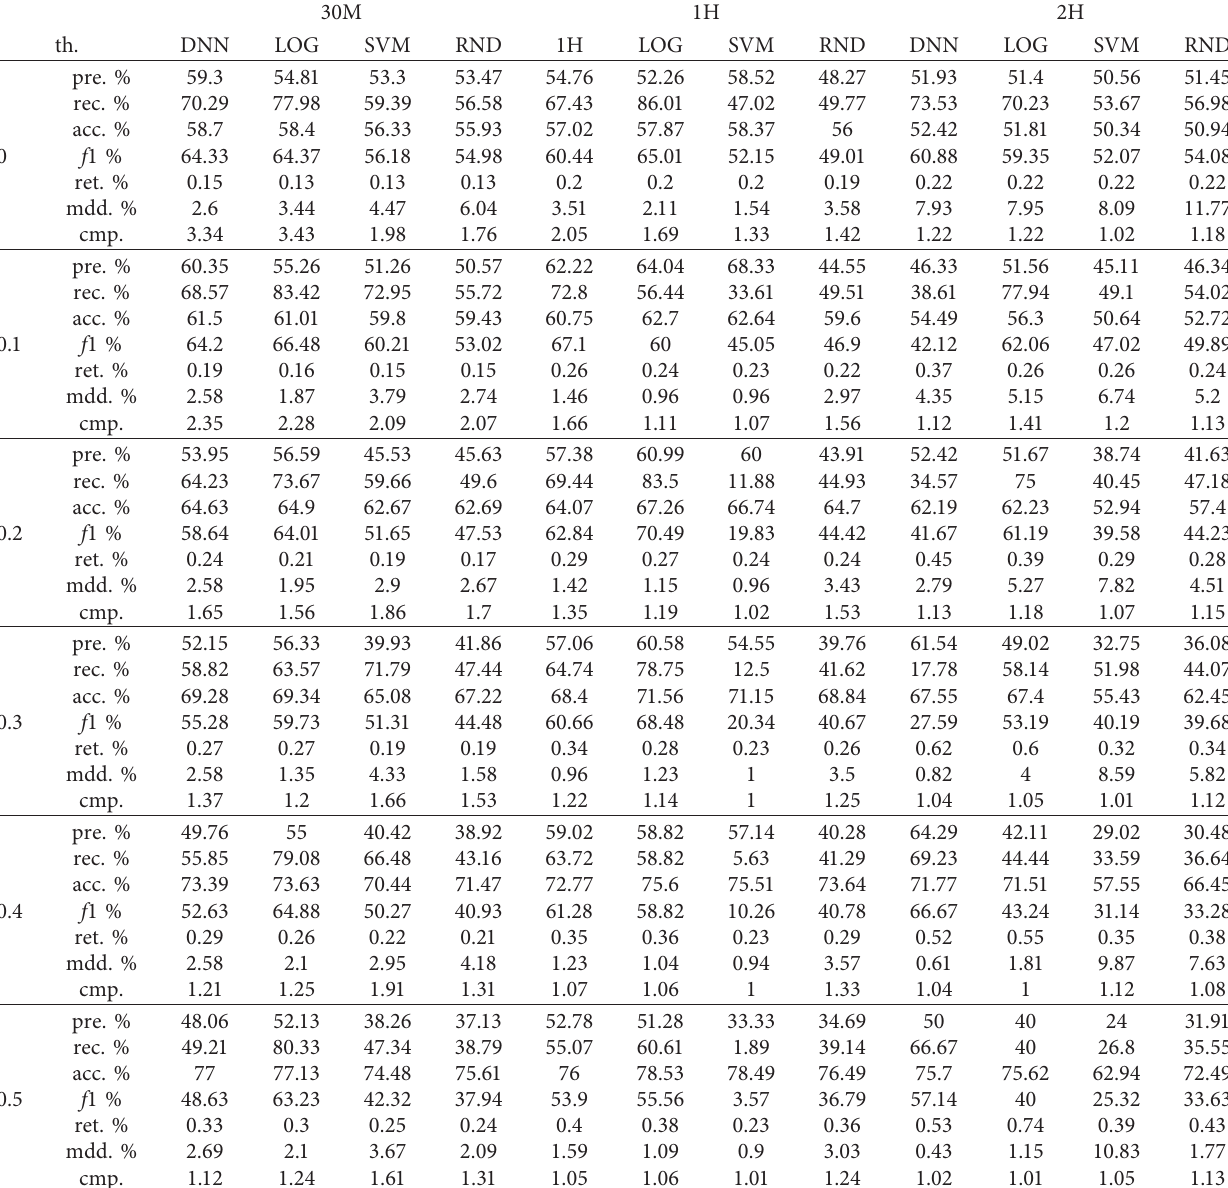
Table 5: Results of rising direction